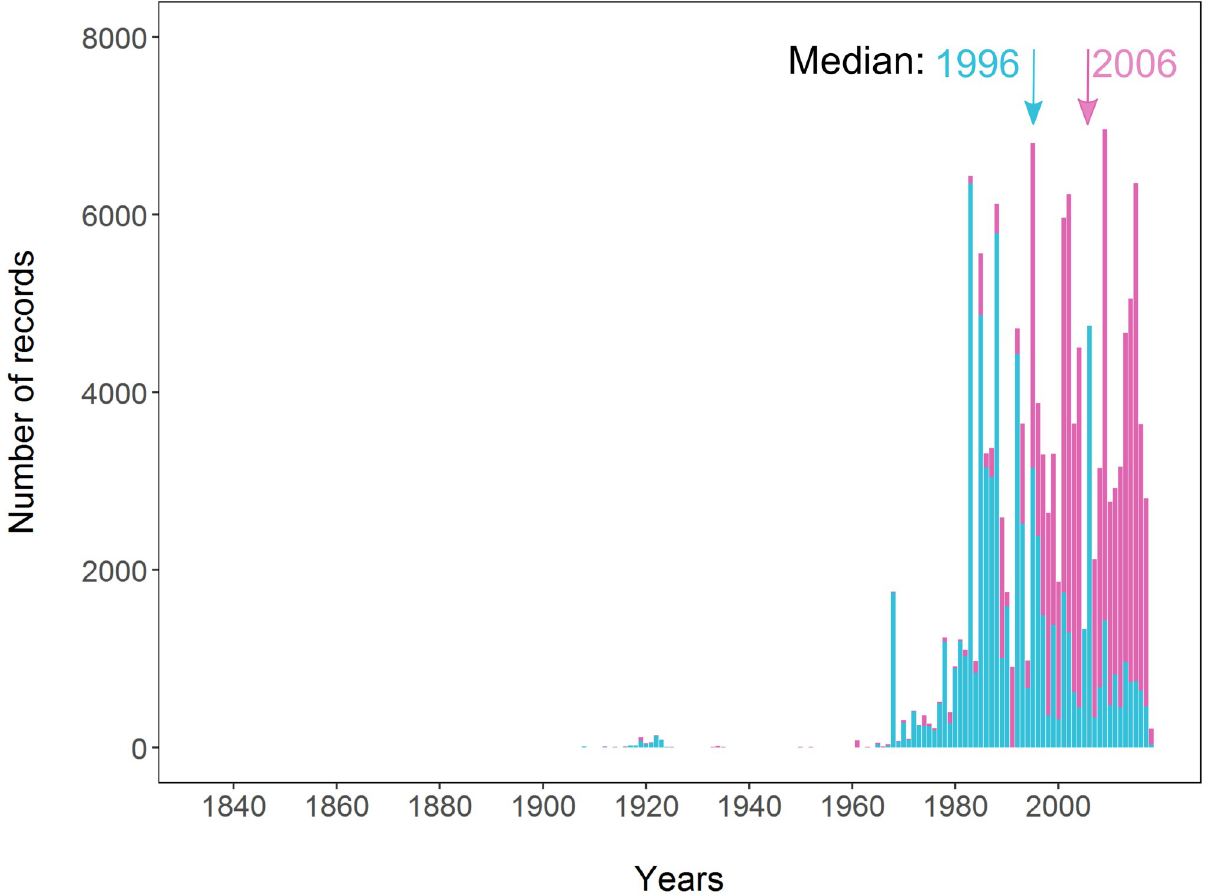
Fig 4. Temporal accumulation of records for non-small mammals (Lagomorpha, Artiodactyla, Carnivora, Chiroptera and Erinaceidae) in pink and small mammals (Rodentia and Soricidae) in blue. Arrows: year containing the data median for each series.